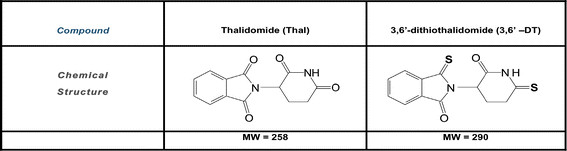
The structures of thalidomide and 3,6′-dithiothalidomide.